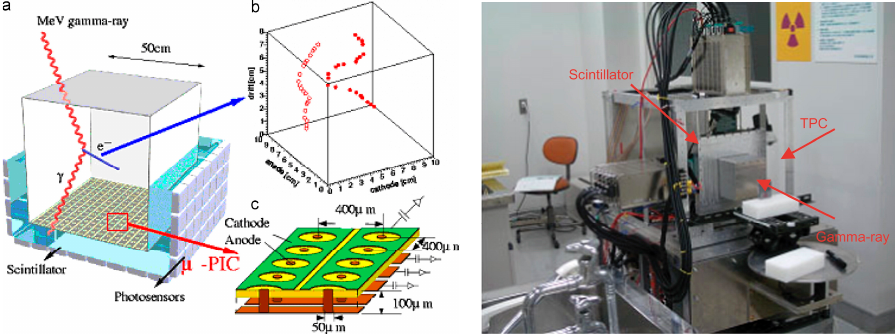
Figure 6. Conceptual structure ( left ( a ) ETCC ( b ) tracks of electrons and ( c ) schematic structure of micro-pixel gas chamber) and actual photograph of ETCC ( right ) developed by Kabuki et al. [129]. Reproduced with permissions from Kabuki et al. [129].